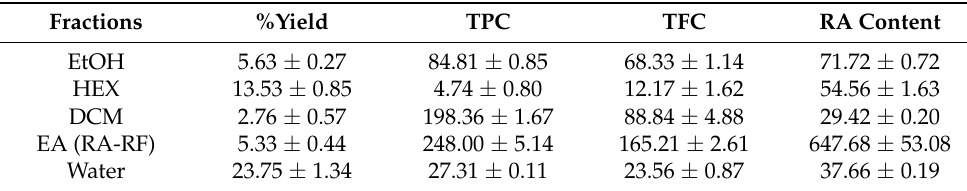
Table 1. Percent yield, TPC, TFC and RA content in PSM extract fractions. Fractions